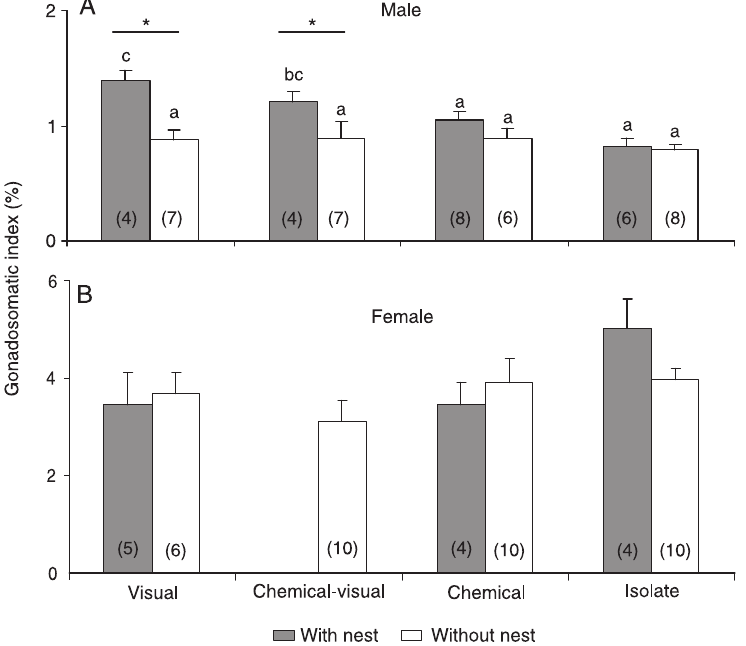
Figure 2. Gonadosomatic index (GSI) of Nile tilapia for each sensorial condition, with and without nests. Data are reported as means ± SEM. Numbers of replicates are indicated within parentheses inside the respective bar. Lines over conditions compare GSI between fish with and without nesting in the same treatment: *P < 0.05 (LSD test). Letters compare means among sensorial groups for the same condition of nest building. Different letters indicate statistically significant differ- ences (*P < 0.05, two-way ANOVA followed by the LSD test).